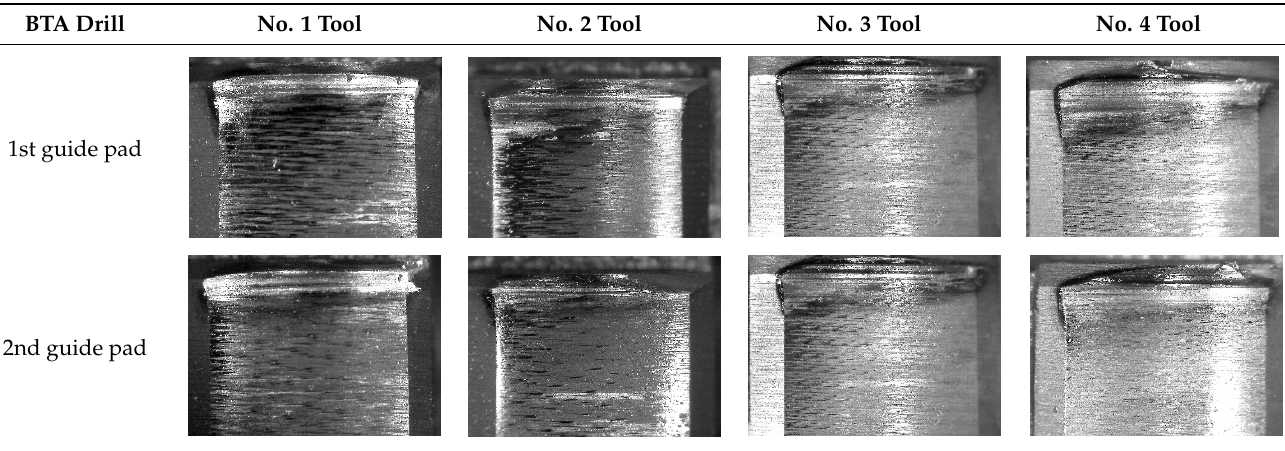
Table 4. Wear morphology of the guide pads of the BTA drill under different drilling conditions.